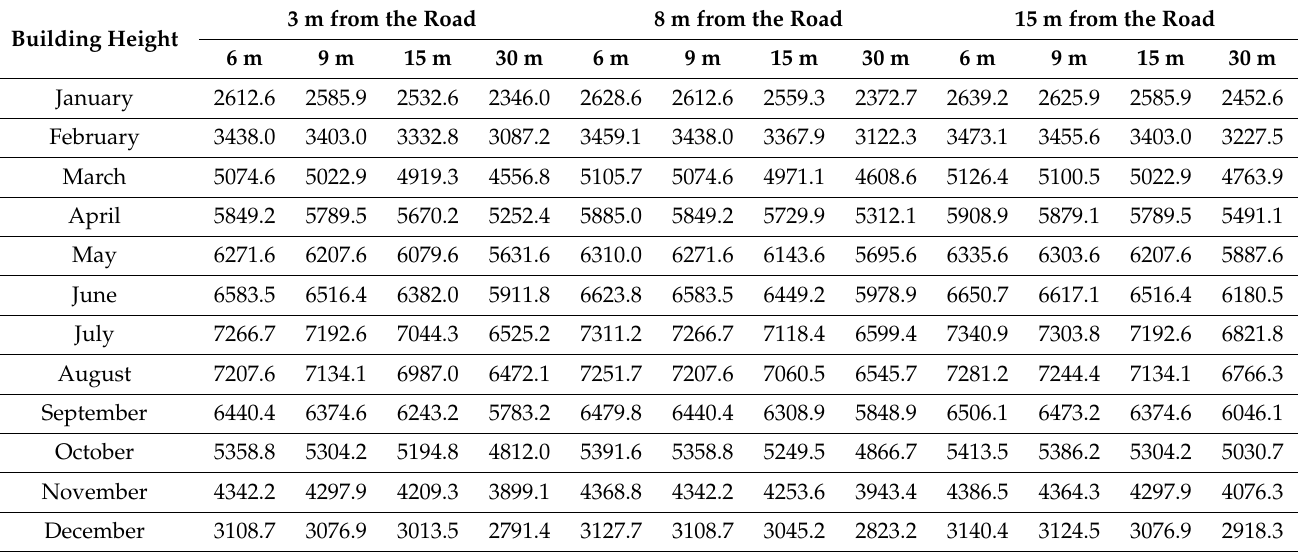
Table 8. Generation results in shadow loss.